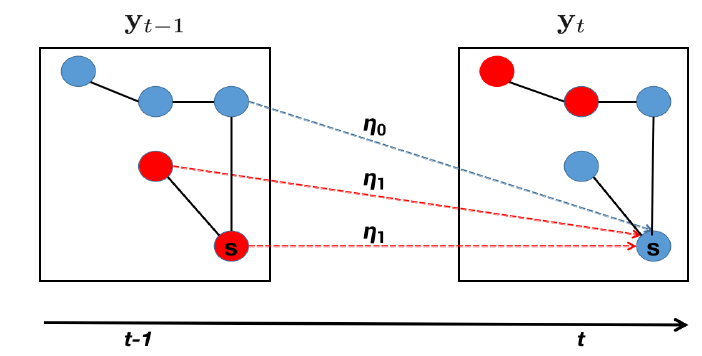
Figure 6. Spatio-temporal representation of the autoregressive structure, where the black square indicates the spatial domain, the colored circles indicate spatial locations, the solid black lines in the black square define the neighborhood of those spatial locations, and the dashed colored lines define the autoregressive dependence at location s . Circles corresponding to water (ice) grid cells are colored blue